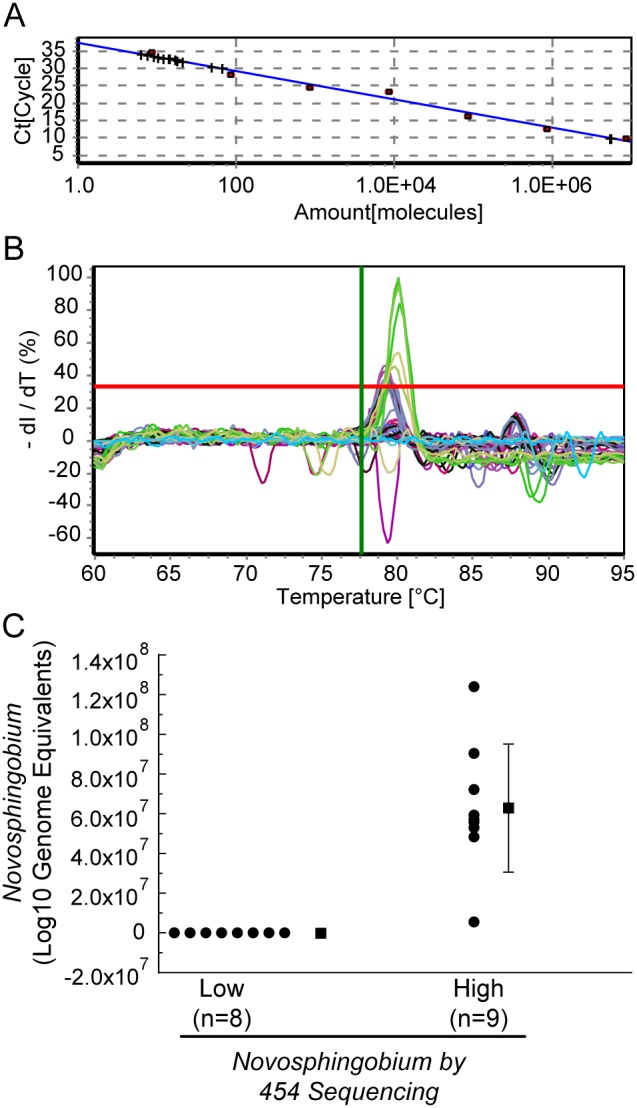
Quantification of Novosphingobium.(A) Standard curve generated using Novosphingobium panipatense and (B) confirmation by melting curve analysis of quantification of levels of Novosphingobium spp. (C) human lung specimens with low or undetectable levels of bacteria by sequencing (n = 8) and specimens with detectable levels of the bacteria (n = 9) by sequencing. An optimized two-step qPCR amplification protocol was used to measure levels of Novosphingobium spp. as described in Methods.